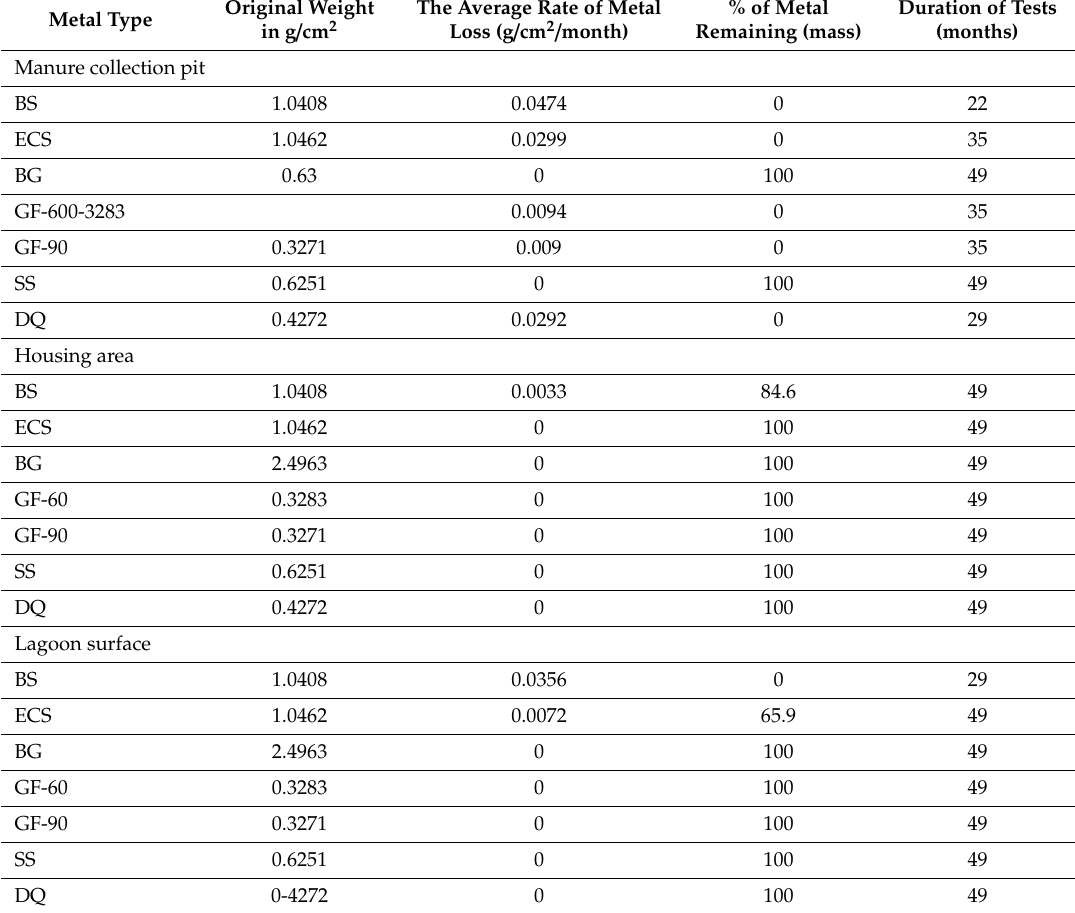
Table 2. Metal losses due to corrosion in poultry manure environments [3]. “Reproduced with permission from Safley, L.M.; Westerman, P.W., Bioresour. Technol. published by Elsevier, 1992”.